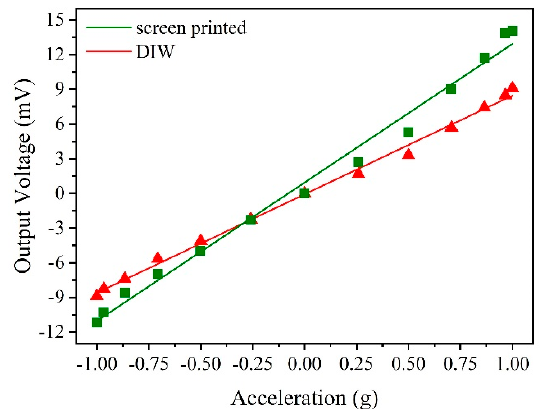
Figure 14. Experimental results of the tumbling experiments.